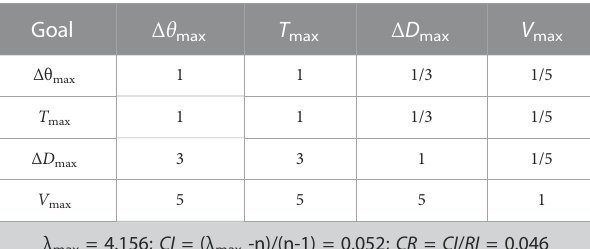
TABLE 4 Level 1 indicator judgement matrix. Goal